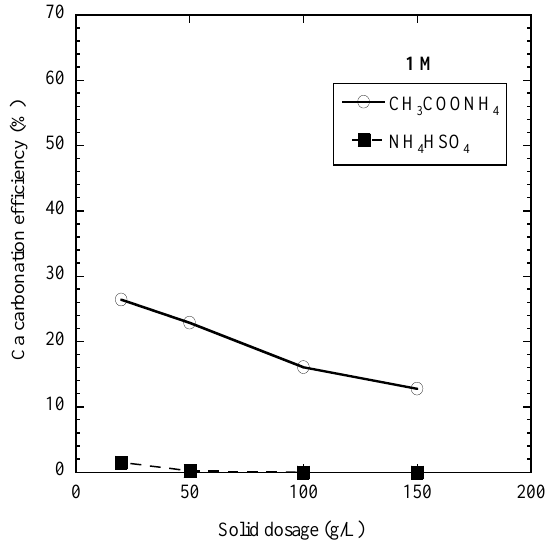
Figure 6. Ca carbonation efficiencies as a function of the solid dosage with the 1.0 M CH COONH and 1.0 M NH HSO solutions for waste slate 3 4 4 4